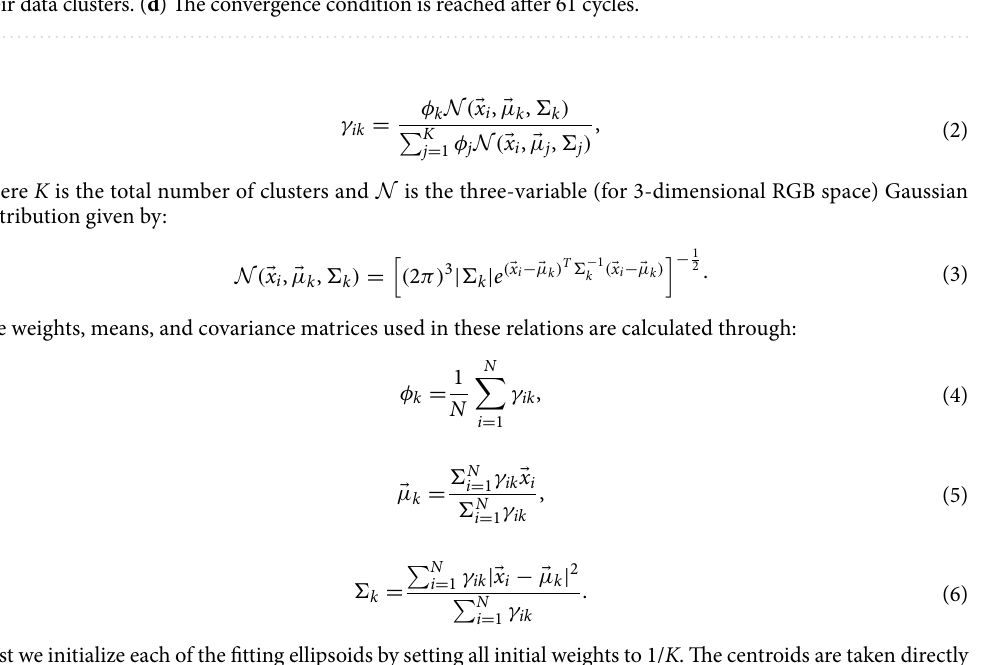
Figure 3. Cluster fitting with a Gaussian mixture model (GMM). The scatter plot from Fig. 1d is superimposed with 95% confidence ellipsoids based on the fit characteristics of the GMM-EM algorithm. ( a ) The initialized ellipsoids show little correspondence to the underlying data. ( b ) After two cycles of expectation-maximization, the ellipsoids better resemble the data clusters. ( c ) After 30 cycles, some ellipsoids have nearly converged on their data clusters. ( d ) The convergence condition is reached after 61